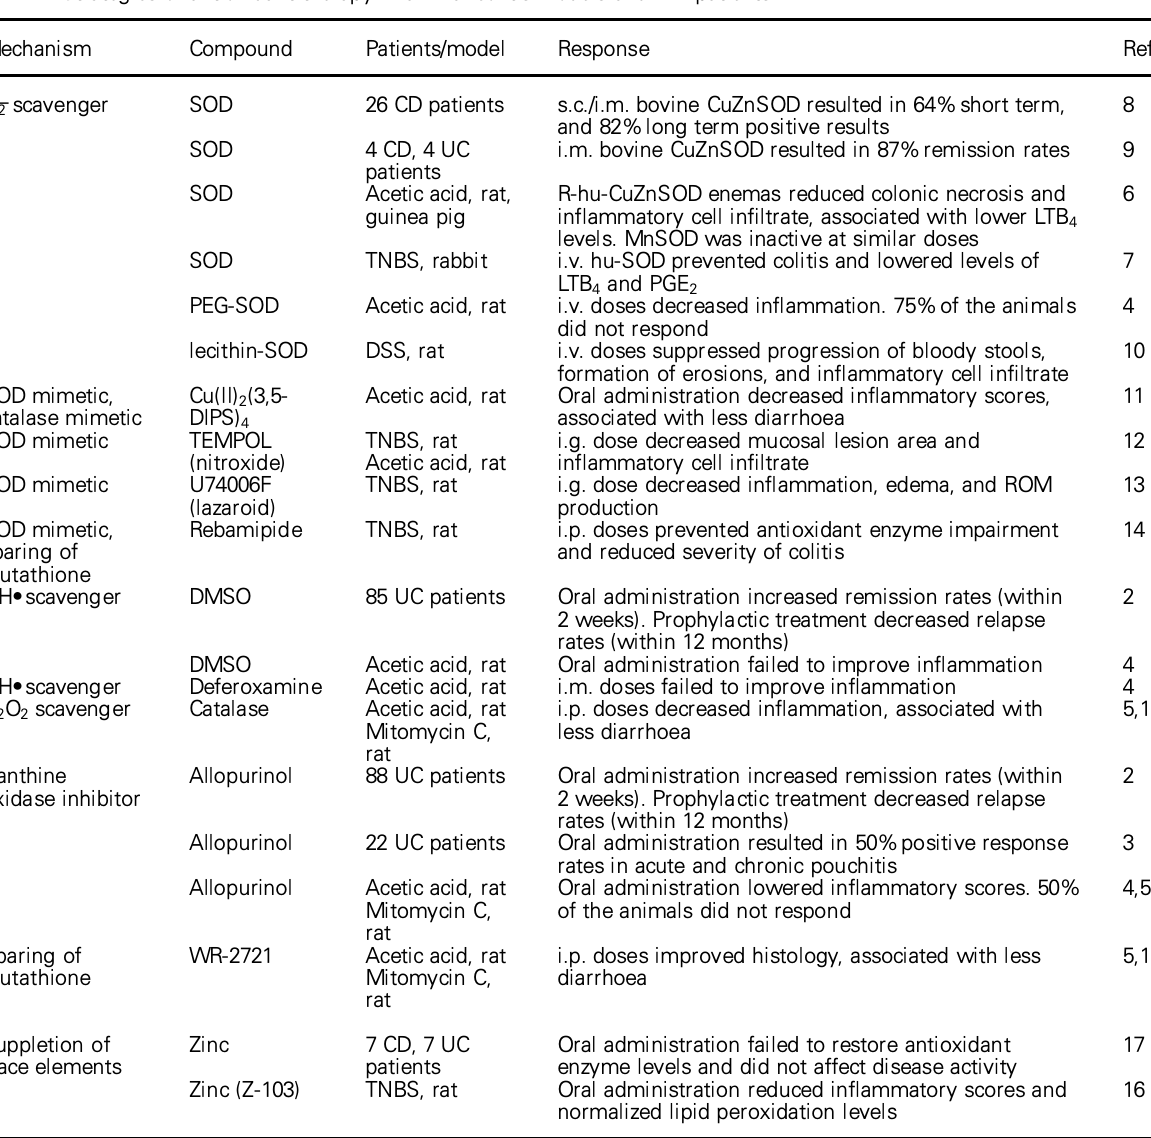
Table 1. Strategies of antioxidant therapy in animal colitis models and IBD patients